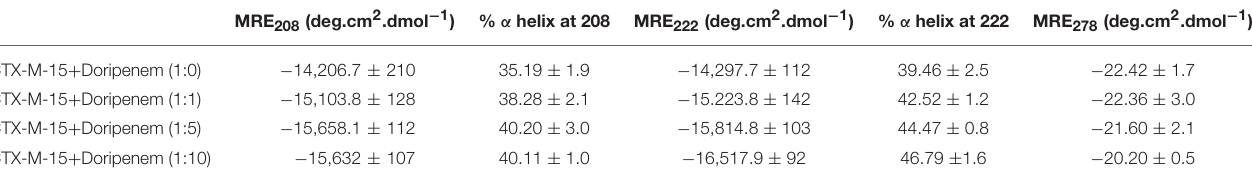
TABLE 3 | Spectral characteristics of CTX-M-15 alone and under doripenem binding condition.